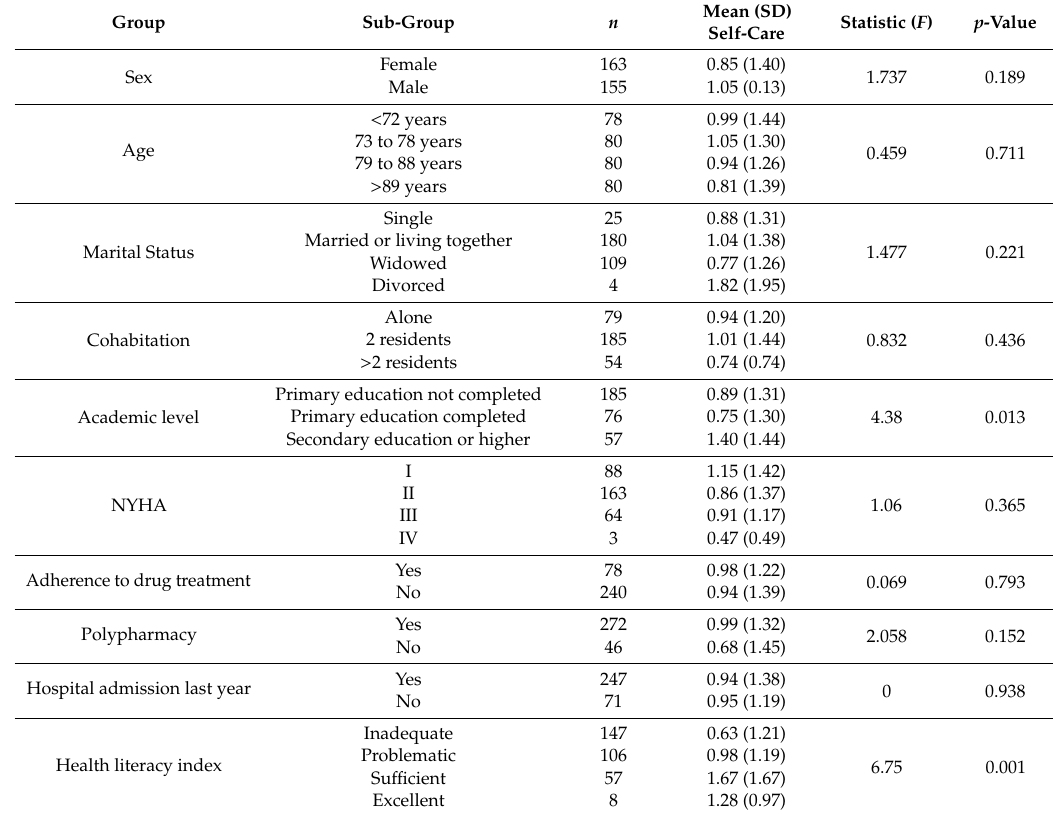
Table 4. Di ff erences between groups in mean self-care practices (ANOVA test).